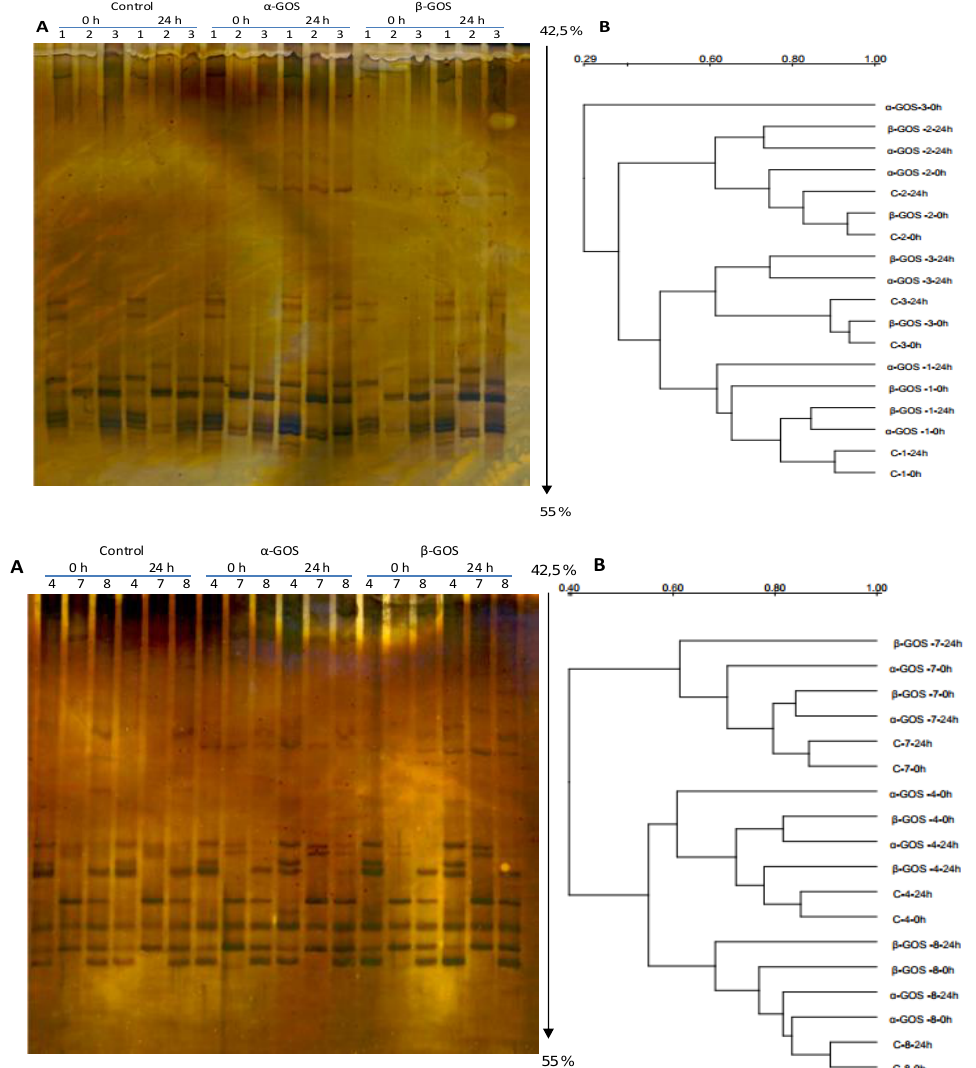
Figure 1. ( A ) DGGE profiles and ( B ) dendrogram of the Bifidobacterium population from faecal samples of six infants and three experimental groups (control, non-fructosylated α -galactooligosaccharides ( α -GOS) and β -galactooligosaccharides ( β -GOS)) at time 0 and 24 h. Samples were grouped in two gels corresponding to 1, 2, 3 and 4, 7, 8 infants, respectively. Cluster analysis of Denaturing Gradient Gel Electrophoresis (DGGE) pattern profiles was performed using the Dice similarity coe ffi cient and the unweighted-pair group method by means of arithmetic average clustering algorithm (UPGMA). The vertical arrow shows the direction and concentration of the denaturing gradient. Table 3. Diversity indices of bifidobacterial samples after non-fructosylated α-GOS and β-GOS 24 h treatment of infant faecal samples.